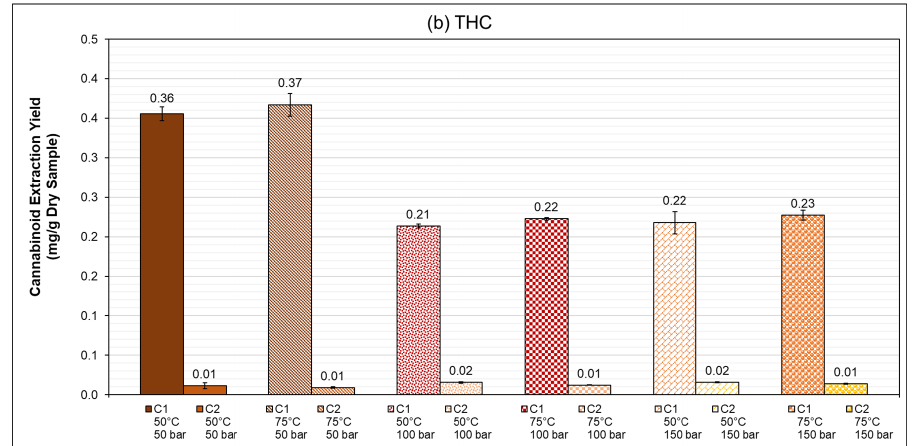
Figure 2. Cannabinoid extraction yield of the pressurized liquid extraction (PLE) experiments performed in the speed extractor (Section 2.4, Table 1). ( a ) CBD, and ( b ) THC. Average value of the duplicates. C1 corresponds to the first extraction and C2 to the subsequent extraction at a given temperature. ANOVA analysis: p -values were below 0.05 for CBD and THC.